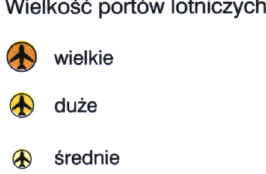
Fig. 7. "Ordered signature symbols" used to show medium, big and great